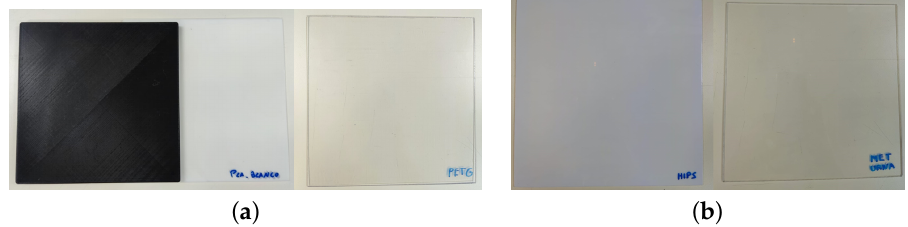
Figure 4. PLA, PETG, HIPS and methacrylate samples: ( a ) PLA white and black ( left ) and PETG ( right ); ( b ) HIPS ( left ) and methacrylate ( right